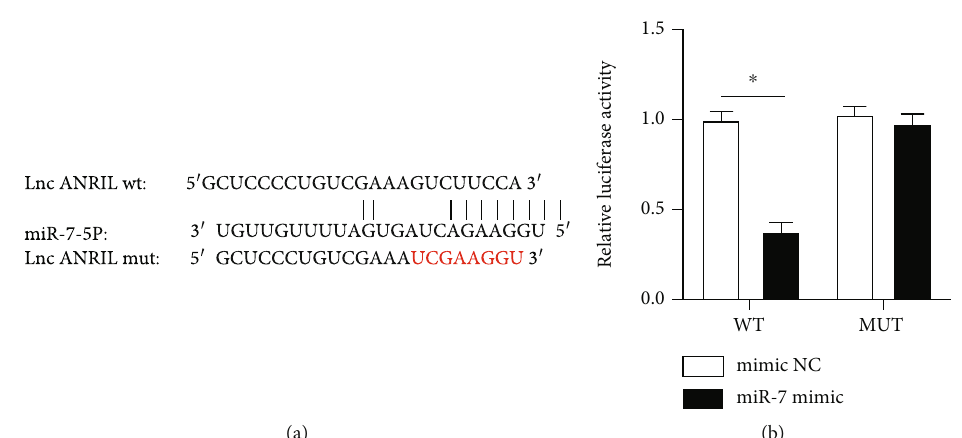
Figure 4: ANRIL sponged to miR-7. (a) The binding sites between ANRIL and miR-7 are shown. The mutant sequences of ANRIL are also shown. (b) HEK293T cells were cotransfected with ANRIL-WT or ANRIL-MUT together with miR-7 mimic or mimic NC, and the relative luciferase activity was detected. ∗ P < 0 : 05 .